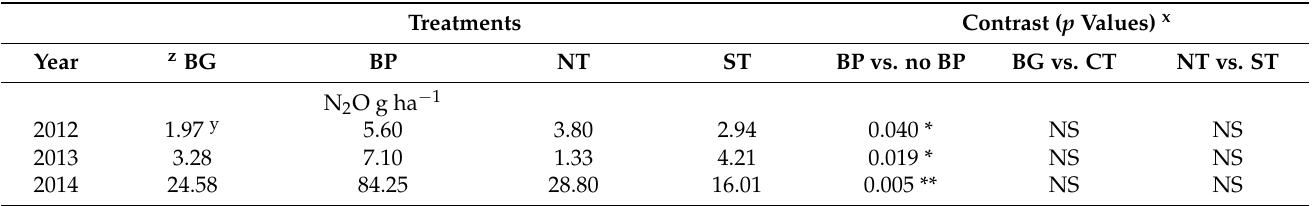
z BG = Bare ground (Conventional tillage without mulch), BP = Conventional tillage with black plastic, NT = no-till, ST = strip-till. y Values are means from four replicated plots repeated measured over 3 times per trial ( n = 12). x Orthogonal contrasts between black plastic vs. no black plastic (BP vs. no BP), bare ground vs. conservation tillage or NT/ST (BG vs. CT), and no-till vs. strip-till (NT vs. ST). * and ** signify contrast significant at p ≤ 0.05 and 0.01,